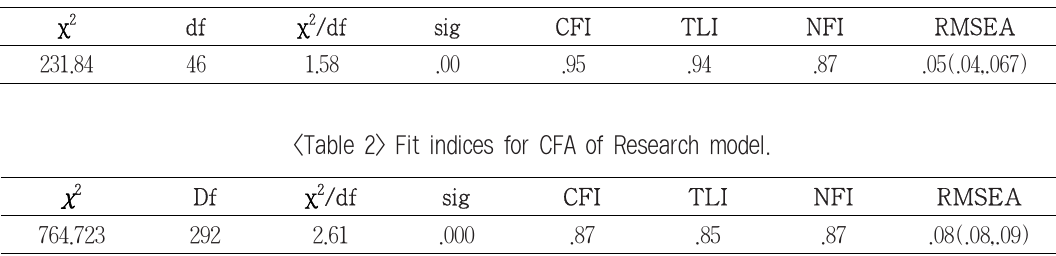
<Table 1> Fit indices for CFA of Perceived Training Effectiveness.